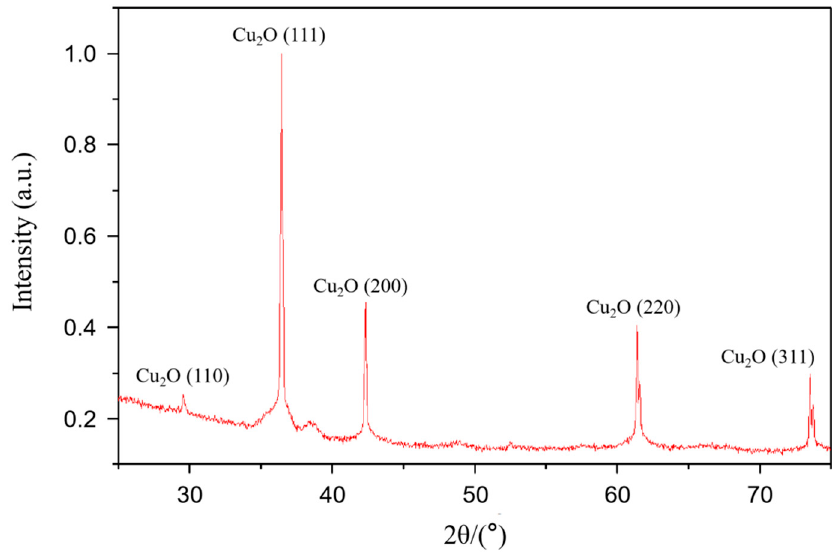
Figure 4. XRD pattern of Cu 2 O nanochains.